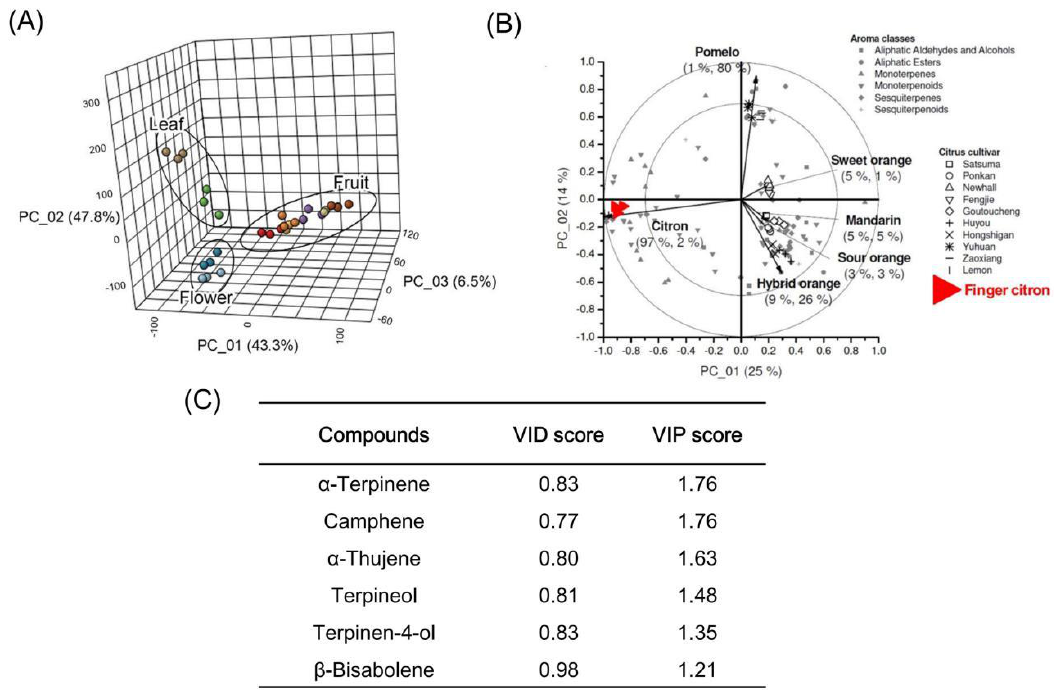
Figure 3. Volatiles ranked by variable identification (VID) and variable importance in projection (VIP) scores. ( A ) partial least squares discriminant analysis (PLS-DA) 3D score plot of finger citron using volatiles as variables. ( B ) PLS bi-plots of eleven Citrus varieties from six species. ( C ) Key volatiles ranked by VID and VIP scores. VID scores were calculated using Unscrambler vs 10.1 according to Shen et al.; VIP score was obtained by PLS-DA using online tool MetaboAnalyst 4.0.